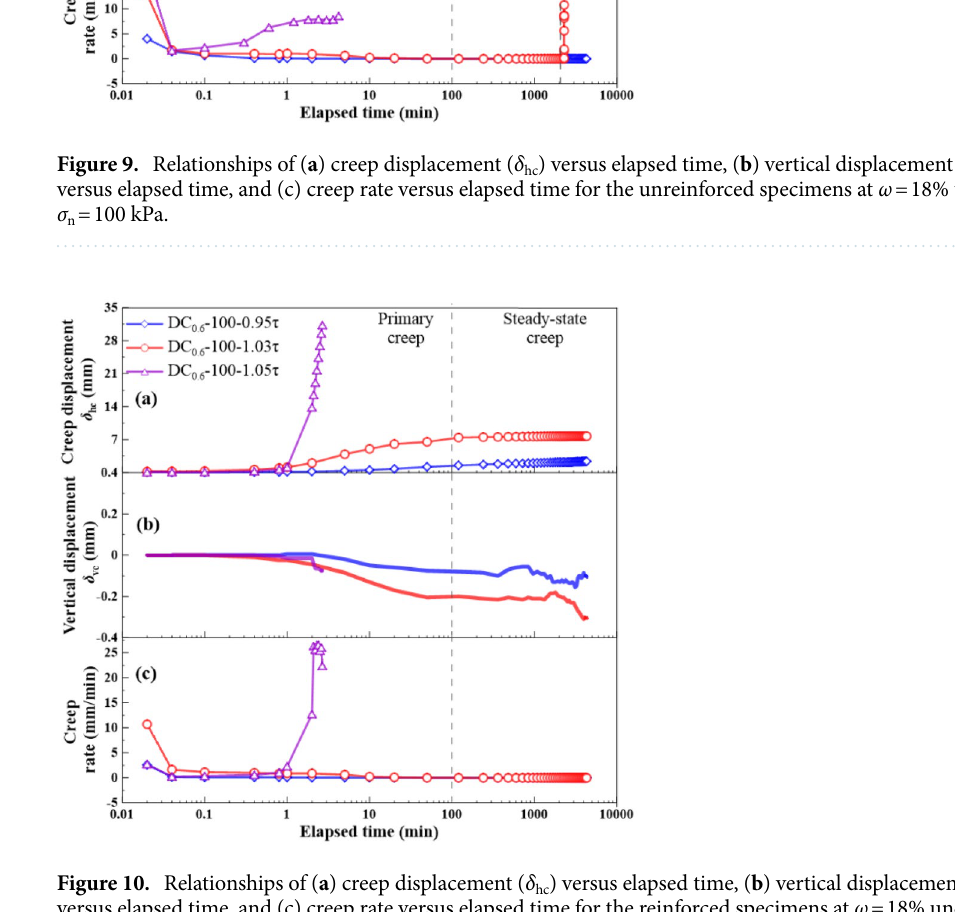
n = 100 kPa and σ n = 300 kPa, followed by the second section ranging from R = 1.02 to